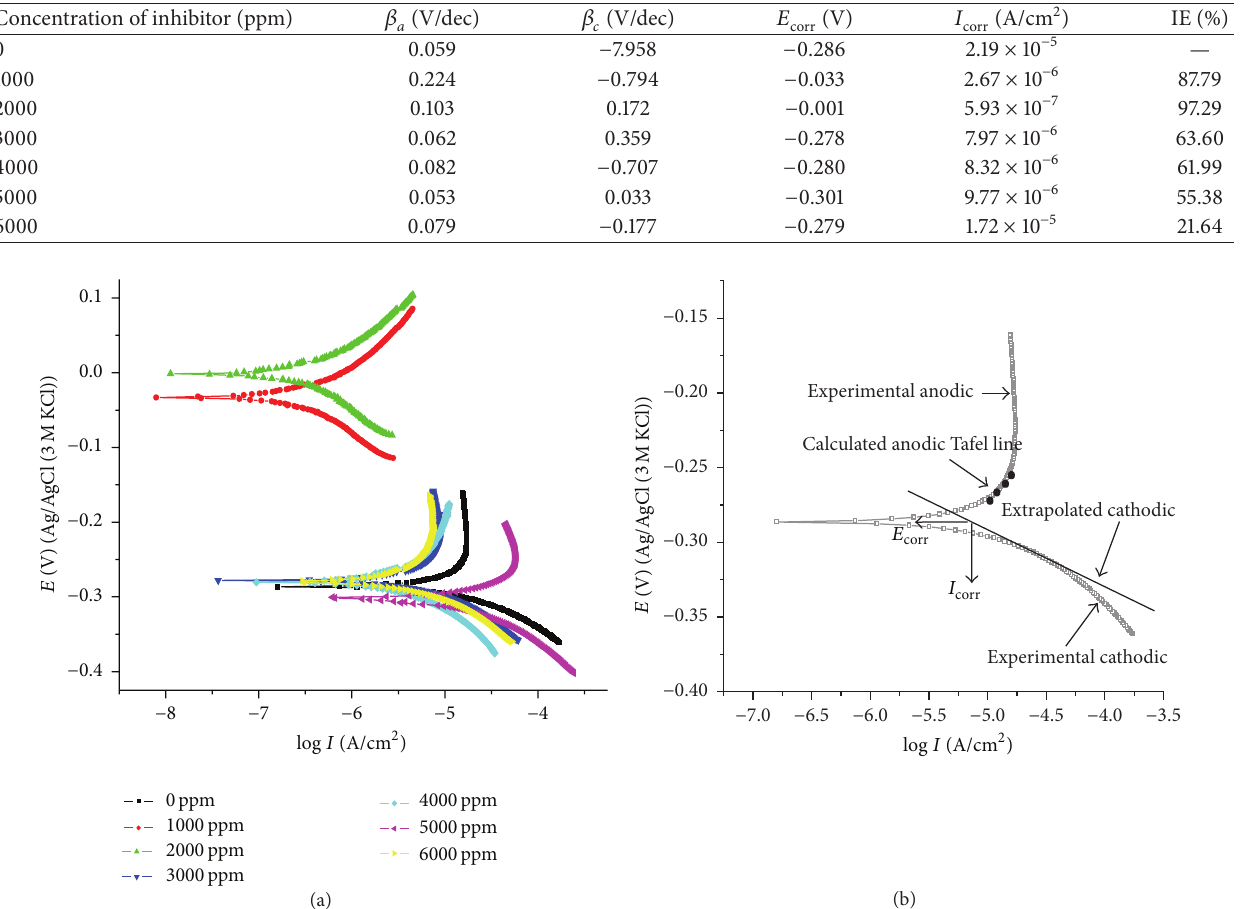
Table 1: Inhibition efficiency calculation of polarization measurements.